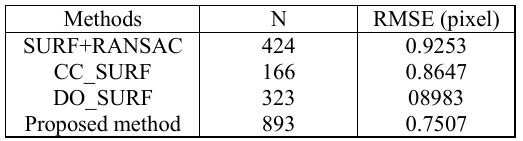
Table 2 Comparison of N and